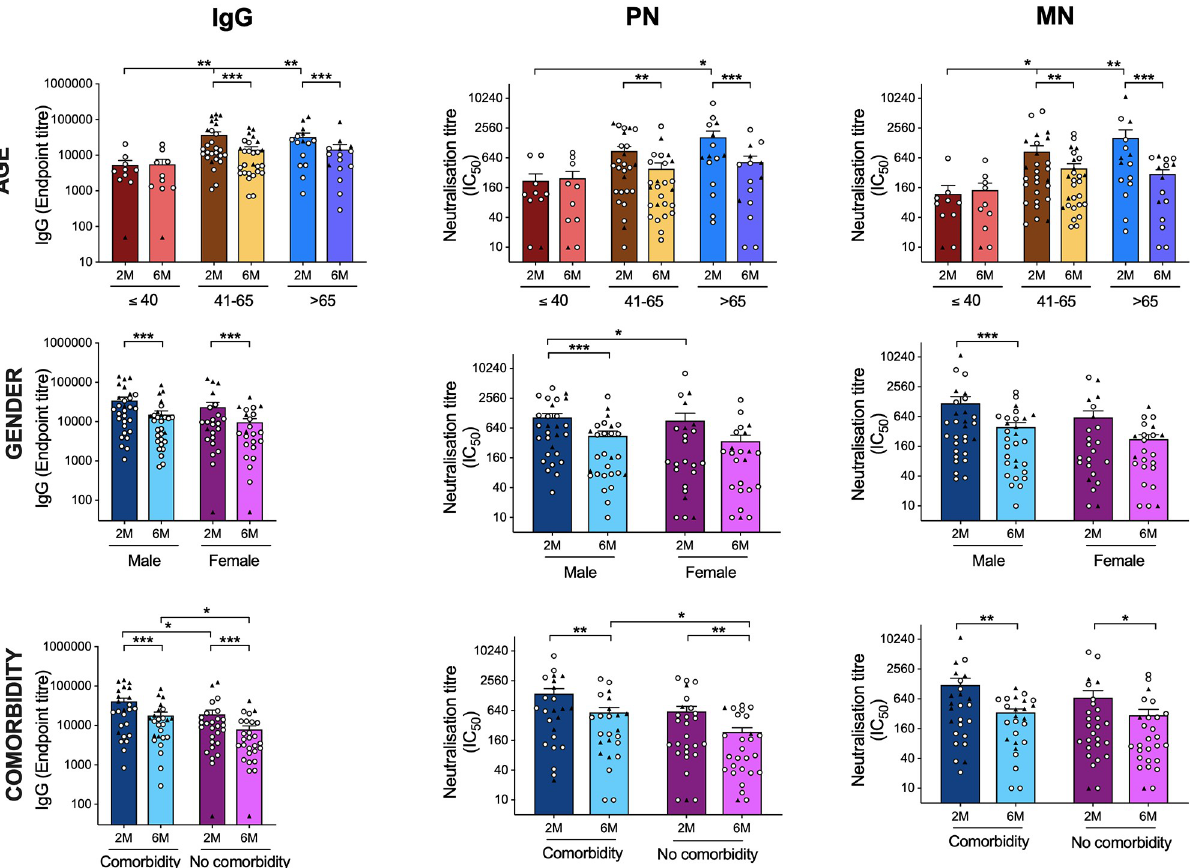
Fig 2. SARS CoV-2 antibody responses by age and gender. Comparison of the SARS-CoV-2 spike-specific and neutralization antibody titers according to age (A-C), gender (D-F) and the presence of comorbidities (G-I) is shown, Spike-specific IgG (A, D, G), PN (B, E, H) and MN (C, F, I). Each symbol represents the SARS-CoV-2 antibodies response from one individual with the circle symbol represents community dwelling patients, and the triangle represents hospitalized patients. The horizontal bars represent the mean T-cell response for each time point ± standard error of the mean. Statistical significance was determined by the non-parametric Kruskal-Wallis multiple comparisons test ( � = P < 0.05).